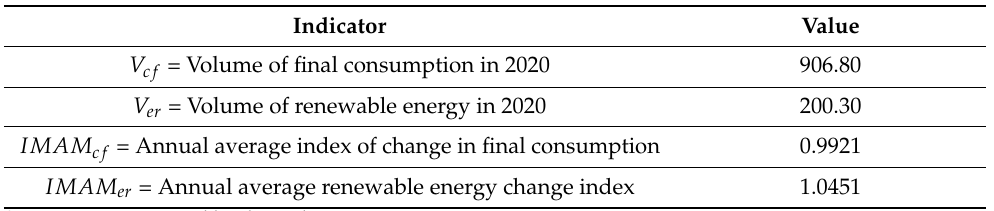
Table 4. Analysis of the evolution of renewable energy and actual final consumption using the average annual change rate. Indicator